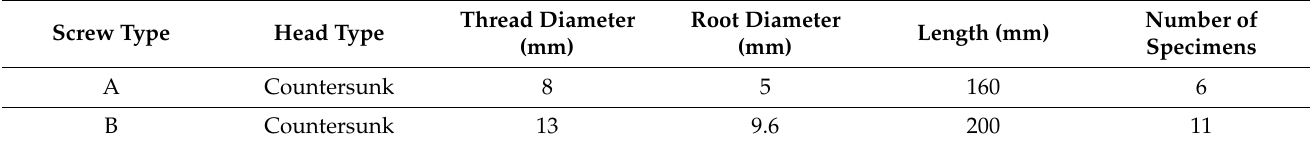
Table 2. Screw configurations tested.